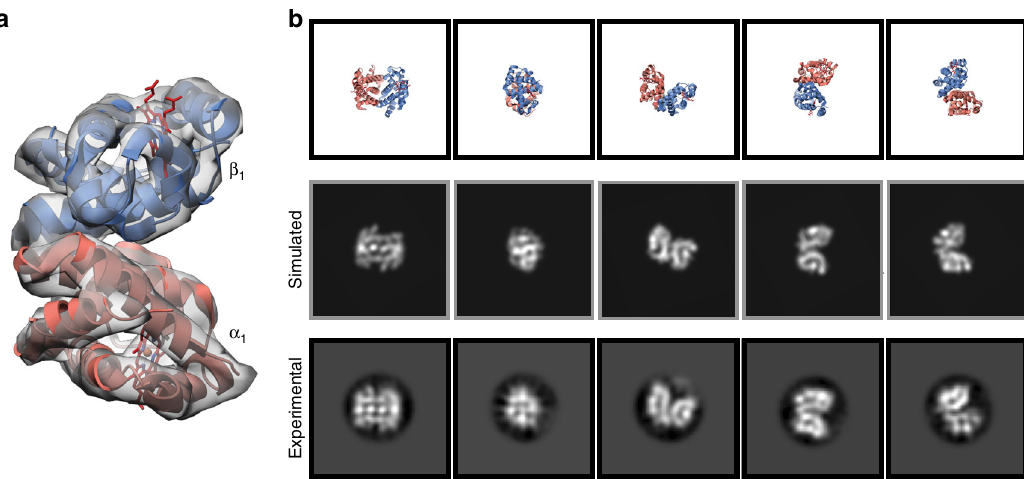
Fig. 4 2D classi fi cation yields classes of ~32 kDa hemoglobin αβ heterodimer. a Simulated EM density of the hemoglobin αβ heterodimer low-pass fi ltered to 8 Å resolution shown as a gray transparent surface. The αβ heterodimer atomic model is shown as ribbon cartoon and the hemes are shown as red sticks. b Views of the hemoglobin αβ heterodimer atomic model (top) and 2D projections of the simulated hemoglobin αβ heterodimer EM density (middle) corresponding to the class averages obtained from 2D classi fi cation (bottom) (see Fig.